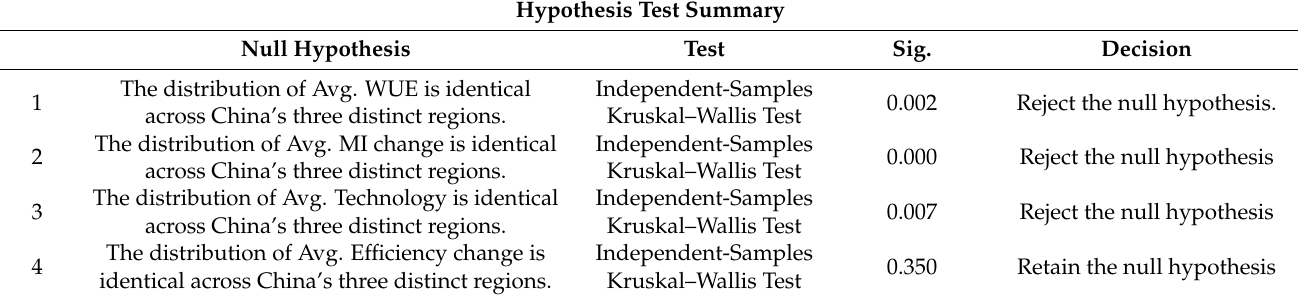
Table 6. The Kruskal–Wallis test indicates the significant statistical difference between WUE and productivity results for the three regions of